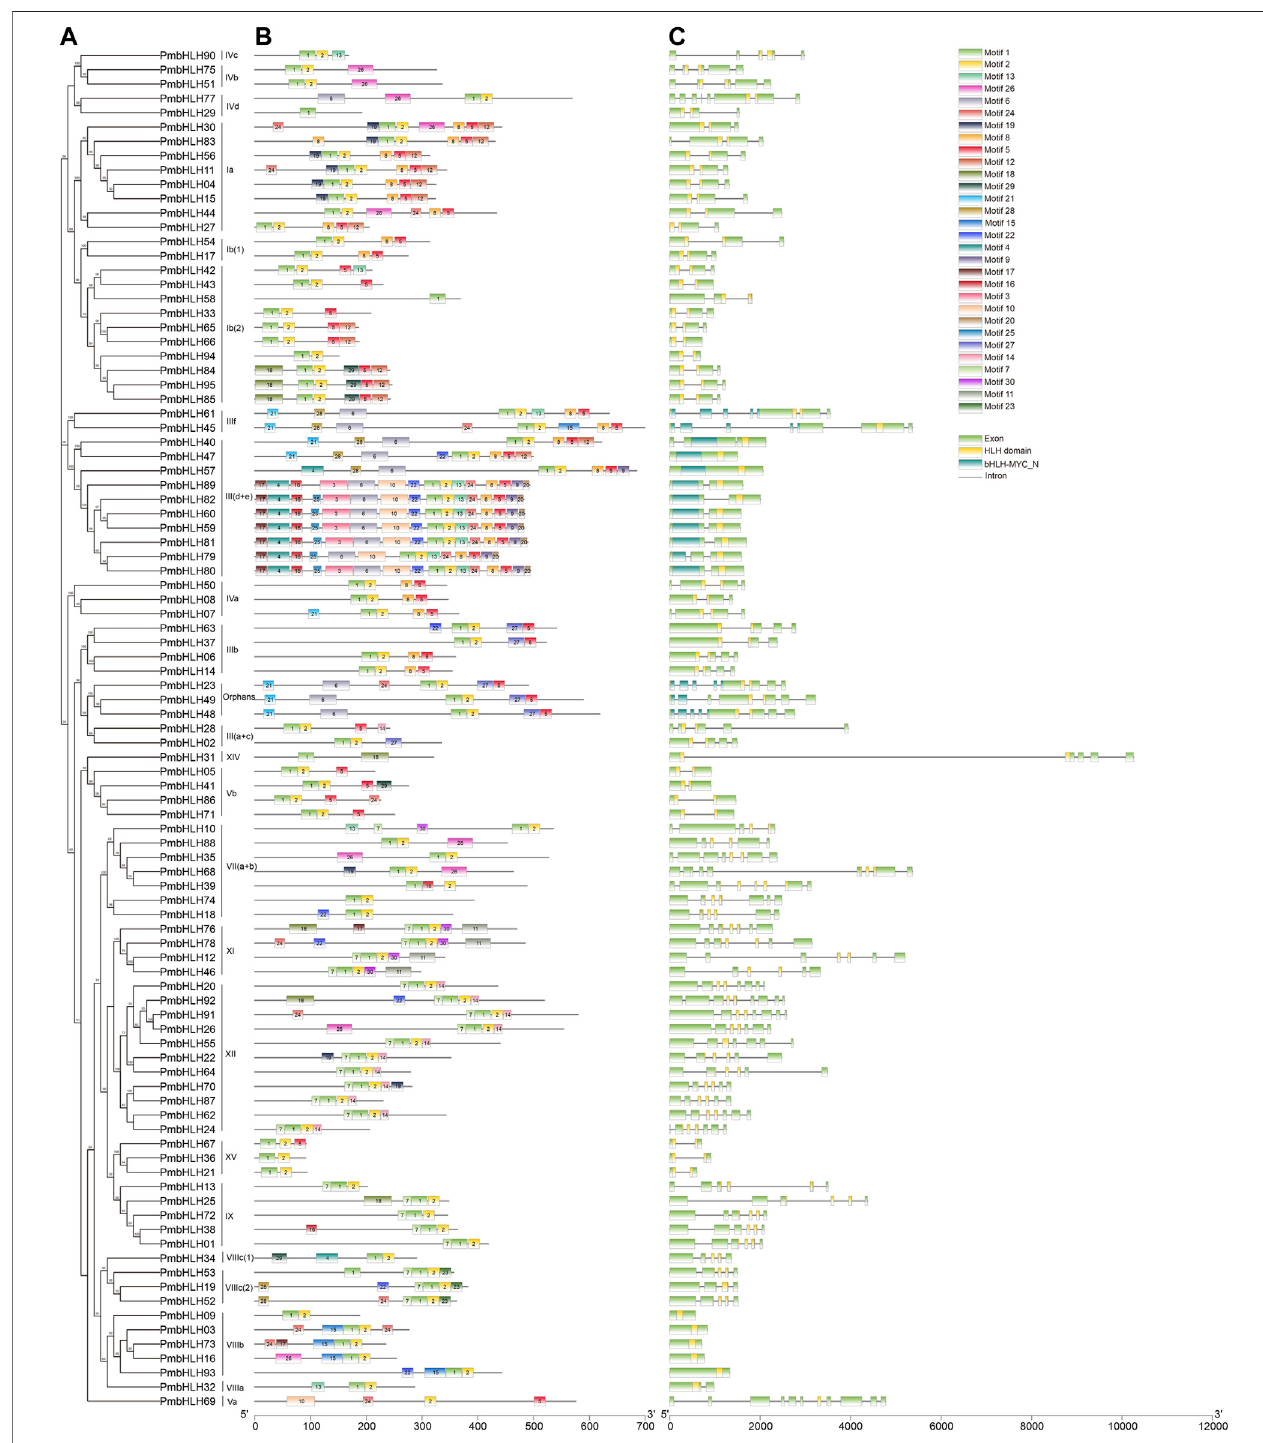
FIGURE 3 | Phylogenetic relationship, motifs analysis, and gene structure in PmbHLH. (A) The RAxML version eight software was applied to construct a phylogenetictreebasedonPmbHLHproteins. (B) MotifcompositionanalysisofPmbHLHsbyMEME.Differentcolorfulrectangleswithnumbers1 – 30representdifferent motifs. (C) Exon-intron structure of PmbHLHs. Grey lines represent introns and green boxes represent exons. Yellow rectangles indicate the position of PmbHLHs conserved domain.